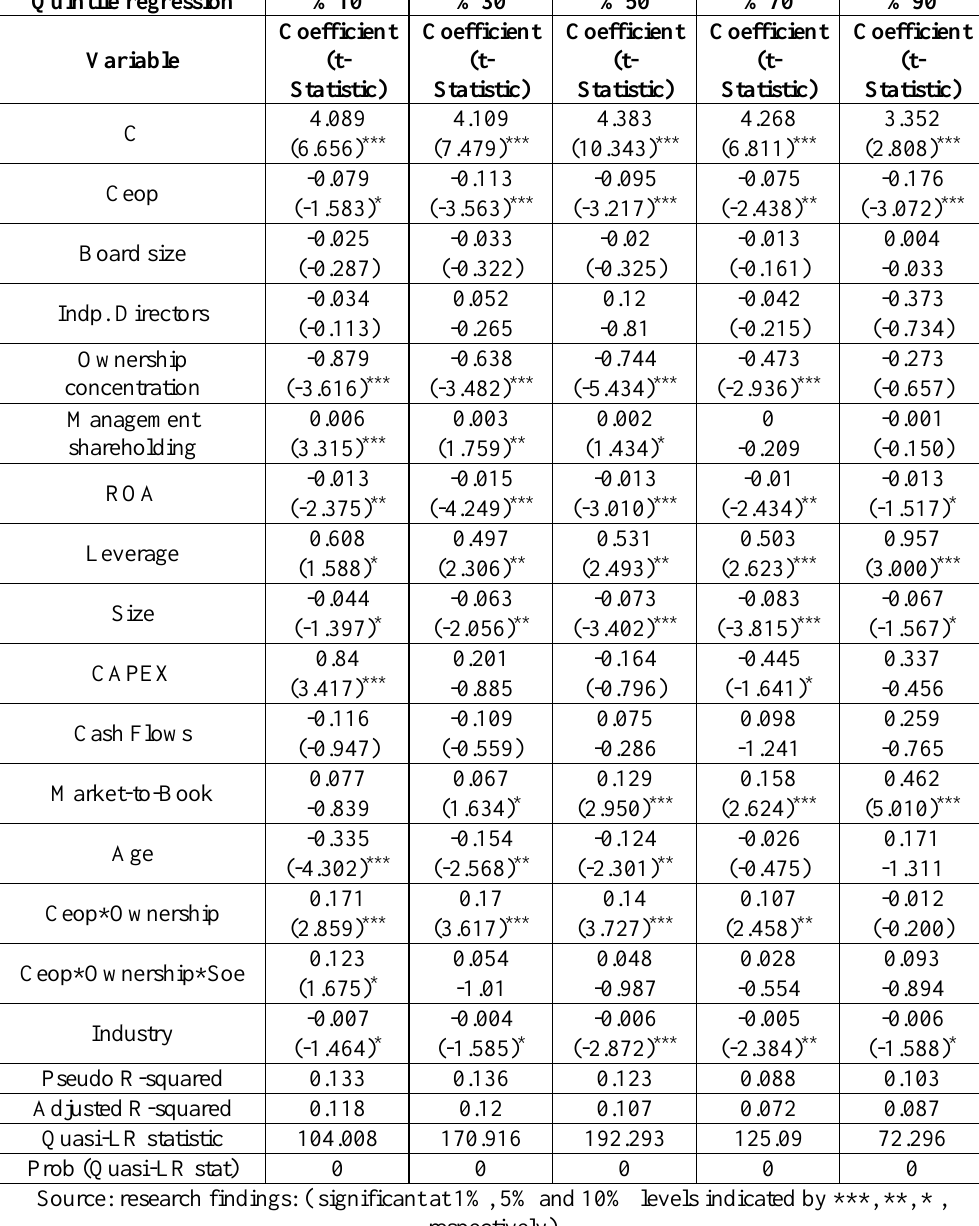
Table 6. fitness results of model 1( dependent variable: general risk of the firm) Quintile